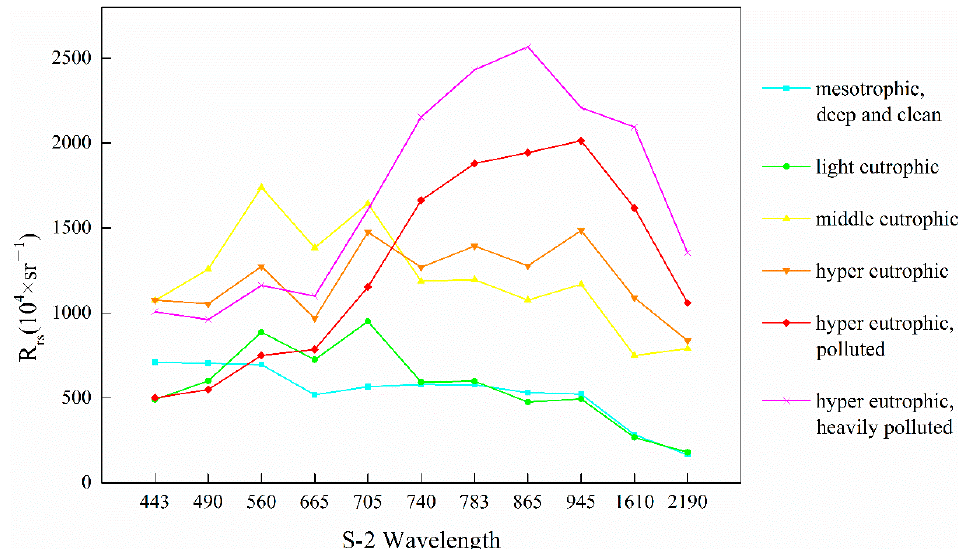
Figure 6. Typical R rs spectra for S-2 multi-spectral instrument (MSI) bands describing urban waters with different trophic states.